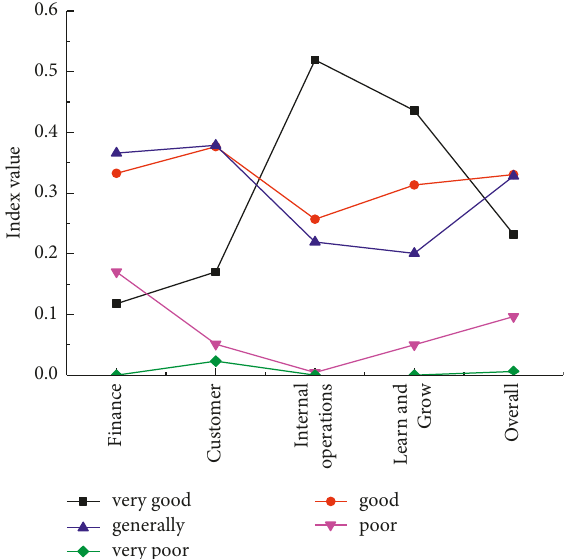
Figure 8: Overall budget performance evaluation results in